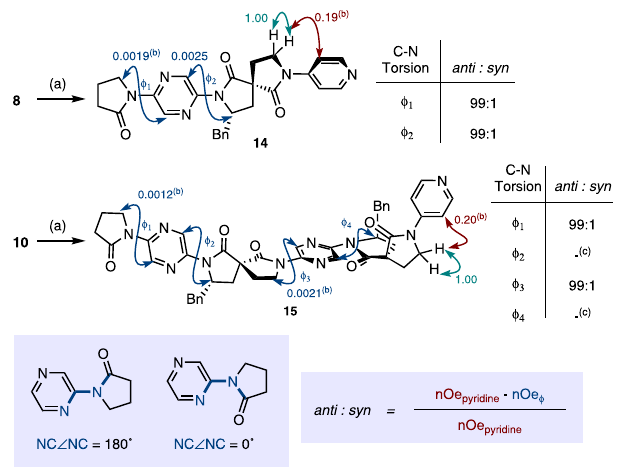
Fig. 4 Analysis of ROESY spectral data for control compounds 14 and 15 (CDCl 3 , t mix 0.2 s). Rotating Frame Overhauser Enhancement Spectroscopy (ROESY) cross-peak intensities are indicated, and normalised relative to the geminal enhancement (in green). anti : syn ratios about each C-N bond are approximated by the formula provided in the inset. This assumes that where cross-peaks are to a pair of diastereotopic methylene hydrogens the average of these intensities is given. a 4-Bromopyridine hydrochloride (1.5 equiv.), Pd 2 (dba) 3 (10 mol%), Xantphos (30 mol%), Cs 2 CO 3 (3.6 equiv.), PhMe, 80 °C, 14 : 4 h reaction, 75% yield, 15 : 3 h reaction, 58% yield; b the average value of the nOe enhancements to both diastereotopic hydrogens is given; c cross-peaks overlap.